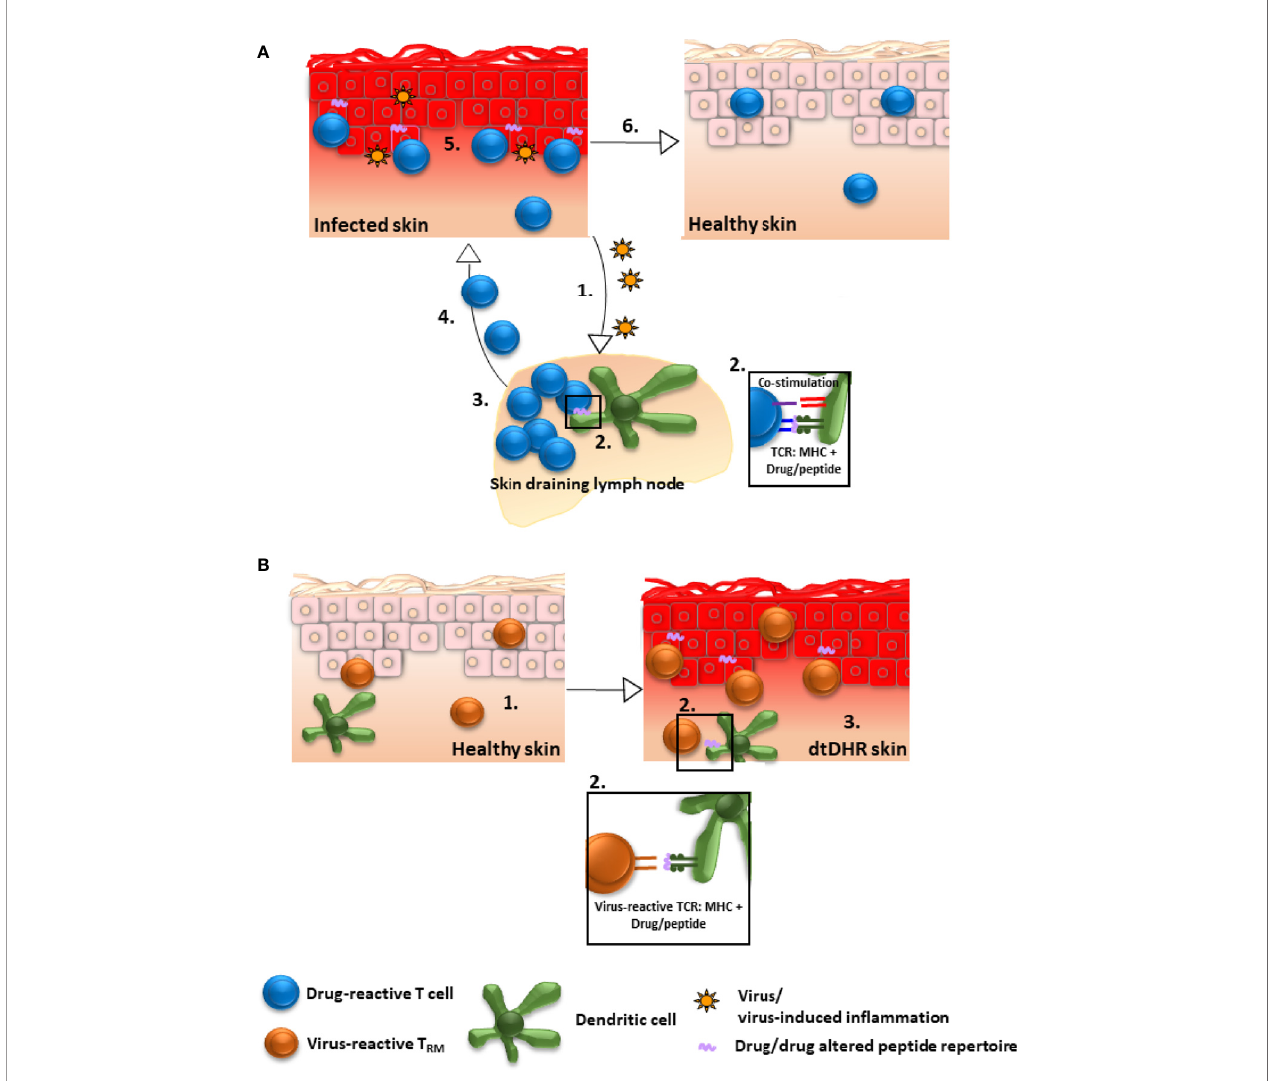
FIGURE 1 | Possible mechanisms by which drug-reactive T RM could be generated in skin. (A) Drug/drug altered peptide repertoire is presented to drug-reactive T cells and concurrent viral infection/reactivation provides suf fi cient co-stimulation to break T cell tolerance to drug: 1. In fl ammatory mediators secondary to infection stimulate dendritic cells. 2. Activated dendritic cells in skin draining lymph nodes present drug/drug altered peptide repertoire to naïve drug-reactive T cells and provide ample co-stimulation resulting in T cell priming. 3. Primed T cells proliferate and differentiate into effector cells, 4. migrate to skin, and 5. mediate damage as a primary immune response. 6. Despite resolution of in fl ammation, drug-reactive T RM remain in skin, poised to mediate repeat dtDHR upon re-exposure to drug. Alternatively, factors other than viral infection, for example altered drug metabolism or reduced clearance, could potentially lead to T cell activation (not shown). (B) Drug-reactive T cells are cross-reactive to viral epitopes: 1. Virus-speci fi c T RM accumulate in skin as a consequence of prior infection. 2. These virus-reactive T cells are capable of recognizing (cross-reacting to) drug/drug altered peptide repertoire presented by MHC on the surface of skin dendritic cells, macrophages and/or keratinocytes resulting in T RM stimulation. 3. The stimulated T RM produce pro-in fl ammatory molecules inducing DRESS, or potentially other